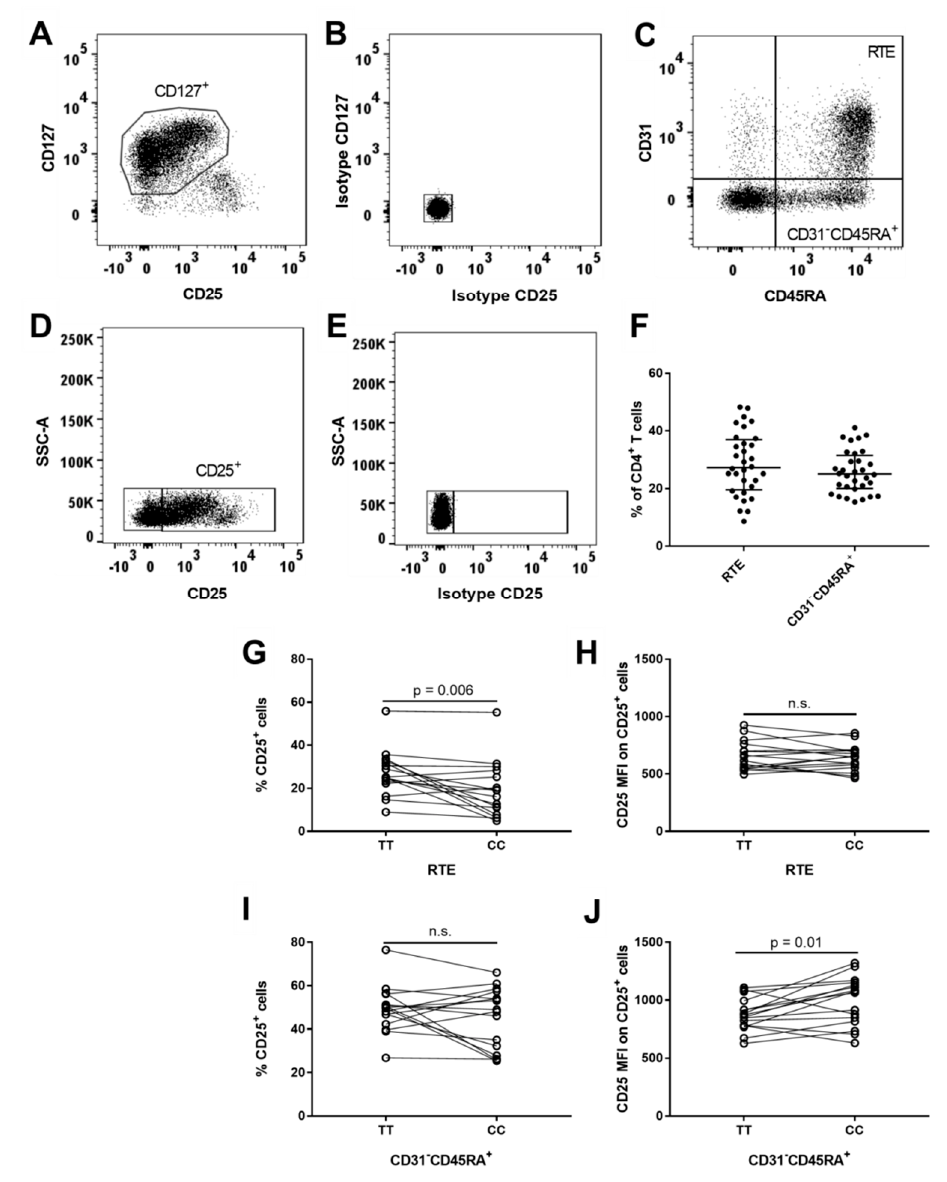
Figure 3. IL2RA genotype associations on recent thymic emigrants and CD31 − CD45RA + CD4 + T cells. ( A ) Gating of CD127 + cells on CD4 + T cells by use of matched isotype control. ( B ) Matched isotype control for CD25 and CD127 on CD4 + T cells. ( C ) Gating of recent thymic emigrants (RTE; CD31 + CD45RA + ) and CD31 − CD45RA + cells. RTE and CD31 − CD45RA + cells are gated from CD127 + CD4 + T cells to exclude contamination from T Reg cells. ( D ) Gating of CD25 + cells on CD4 + T cells by use of matched isotype control. ( E ) Matched isotype control for CD25. ( F ) Frequency of recent thymic emigrant (RTE; CD31 + CD45RA + ) cells and CD31 − CD45RA + cells in relation to CD4 + T cells. ( G , I ) Homozygous carriers of both MS-associated IL2RA SNPs rs2104286 and rs11256593 are defined by TT for the risk genotype and CC for the protective genotype. Differences between TT carriers (N = 16) and CC carriers (N = 16) on frequency of CD25 + cells in RTE (Paired t test, mean of difference = − 8.0; 95% CI = − 13.5 to − 2.6) and CD31 − CD45RA + (Paired t test, mean of difference = − 4.3; 95% CI = − 11.4 to 2.7) T cells. ( H , J ) Differences between TT carriers (N = 16) and CC carriers (N = 16) on surface expression (MFI) of CD25 in CD25 + RTE (Paired t test, mean of difference = − 17.8; 95% CI = − 67.1 to 31.6) and CD25 + CD31 − CD45RA + (Paired t test, mean of difference = 120.3; 95% CI = 29.3 to 211.3) cells. 3.4. Lower Frequency of CD25 + T FH 1 Cells in Carriers of the IL2RA Risk Genotype